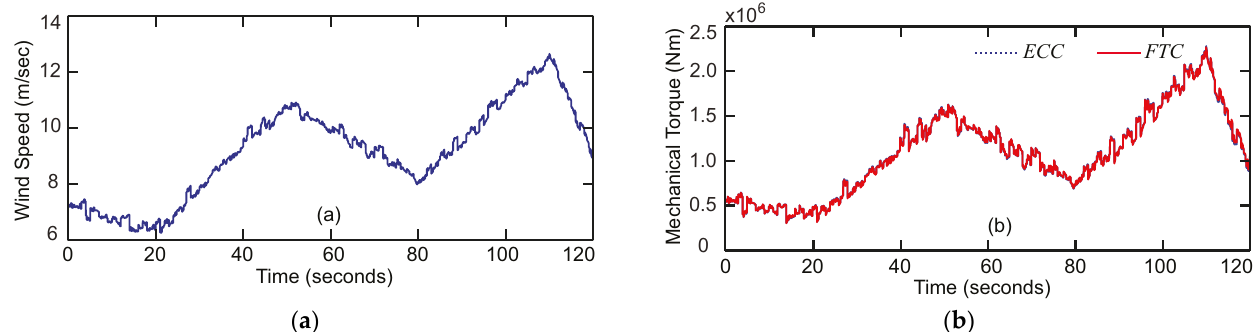
Figure 4. Input and output of the wind turbine: ( a ) wind speed profile and ( b ) mechanical output torque of the wind turbine.